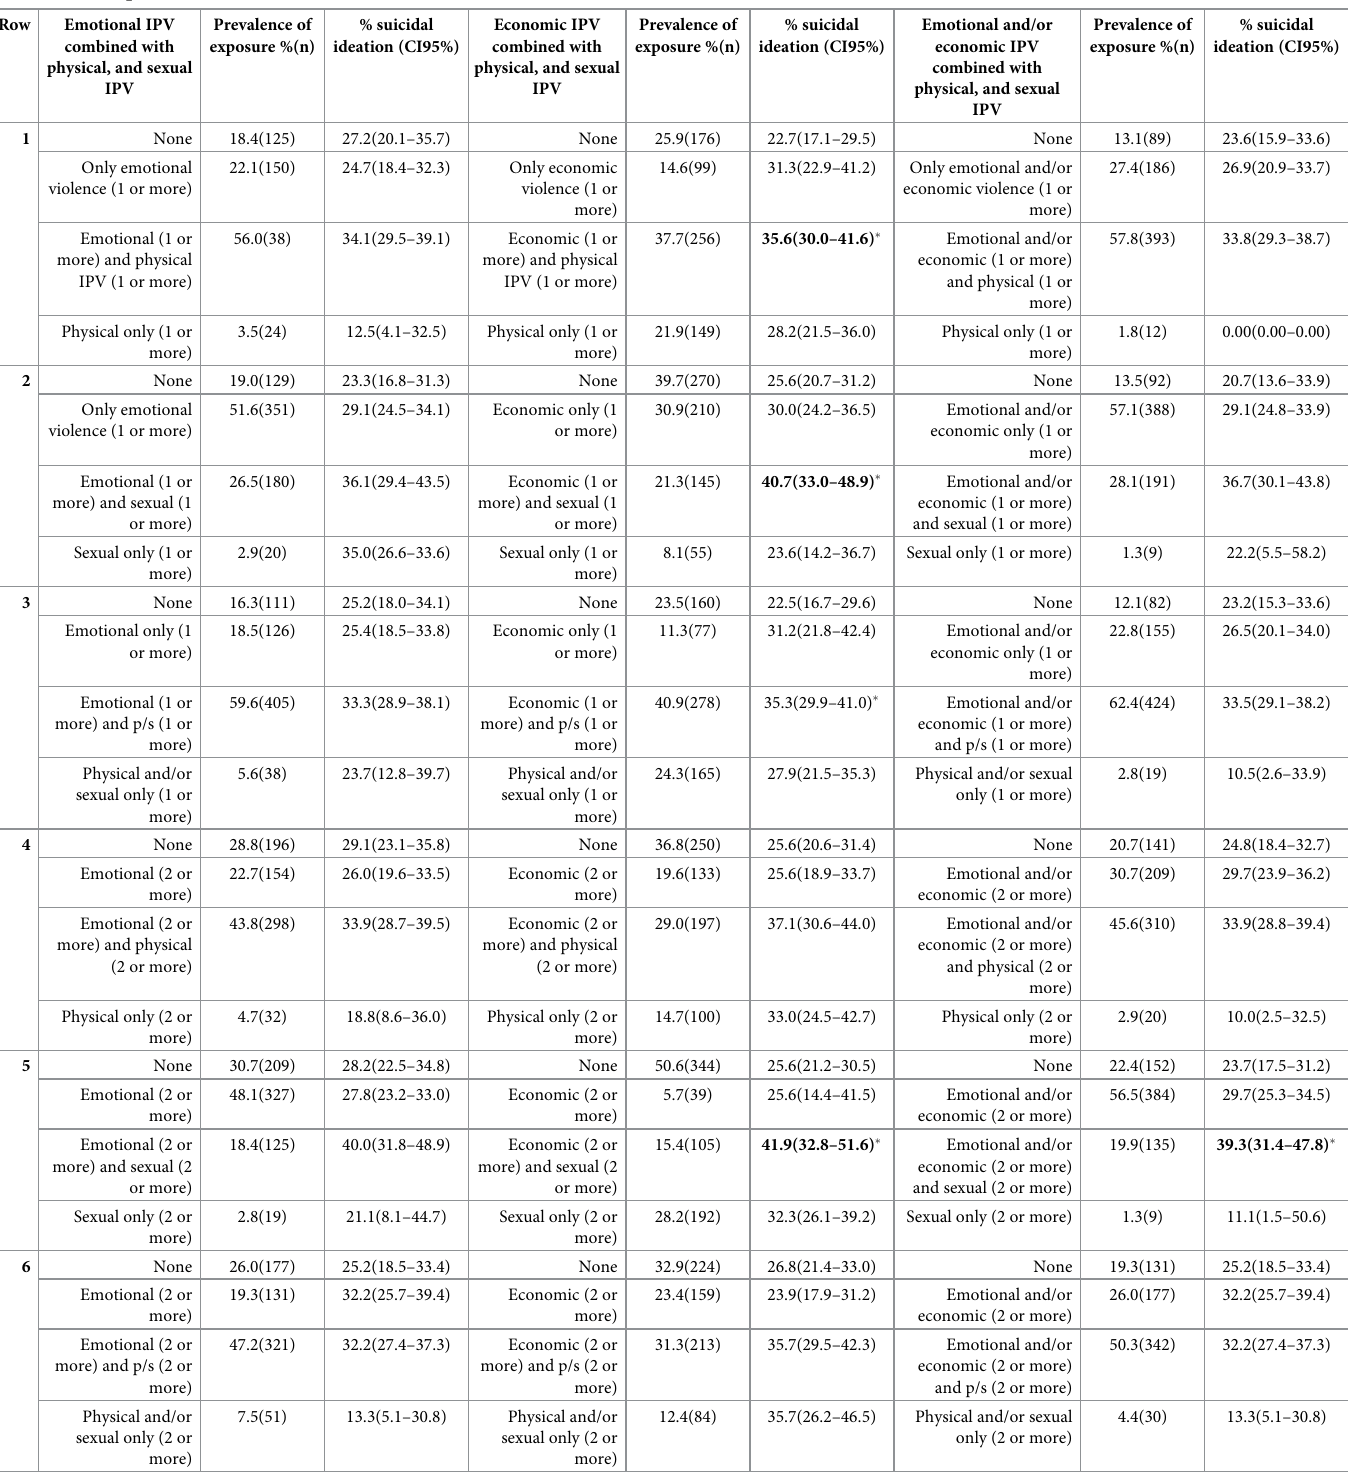
Table 5. Descriptive associations between suicidal ideation and combinations of IPV.